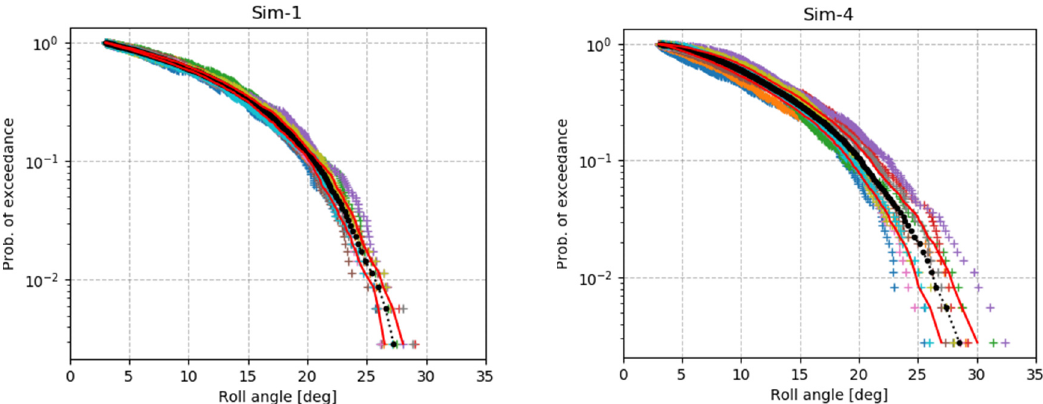
Figure 5. Extreme value distributions of the roll motions from programs Sim-1 (left) and Sim-4 (right) for 10 realisations of the wave. Simulations were run in following seas with Hs = 4 m, Tp = 13.5 s and average speedVs = 7.9 kn.